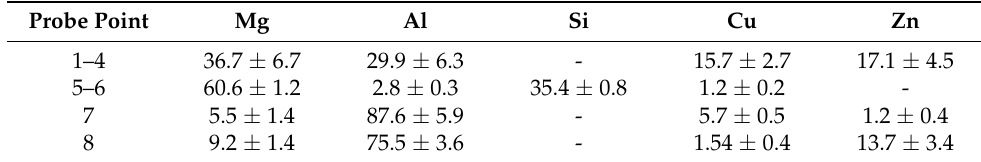
Table 5. EDS of the core-shell ν -phase/Mg 2 Si/Al-Zn-Cu-Mg particle.